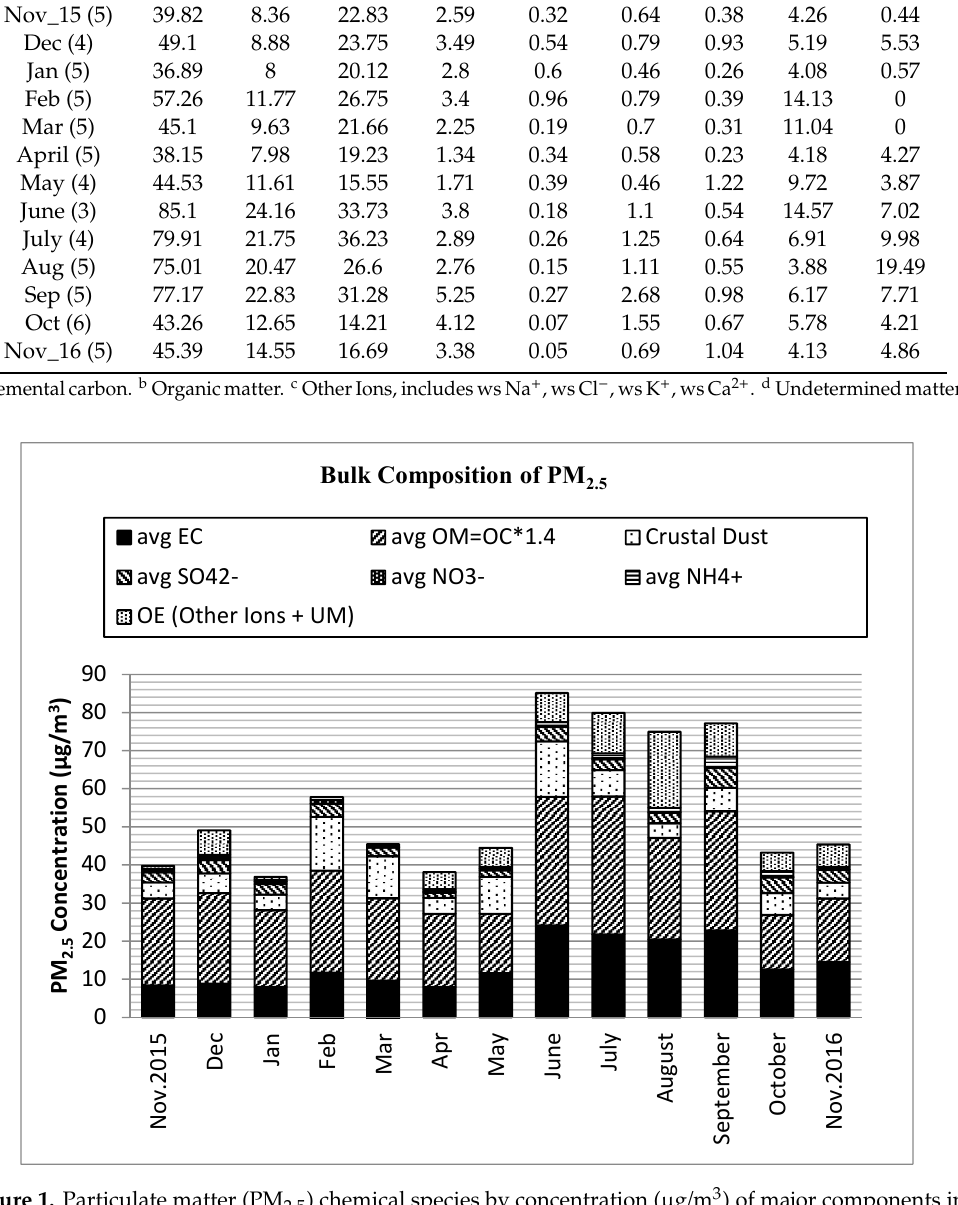
Figure 1. Particulate matter (PM 2.5 ) chemical species by concentration ( µ g / m 3 ) of major components in Addis Ababa; EC = Elemental carbon. OM = Organic matter. OE = Other elements. Other Ions = ws Na + , ws Cl − , ws K + , ws Ca 2 + . Other = Unidentified